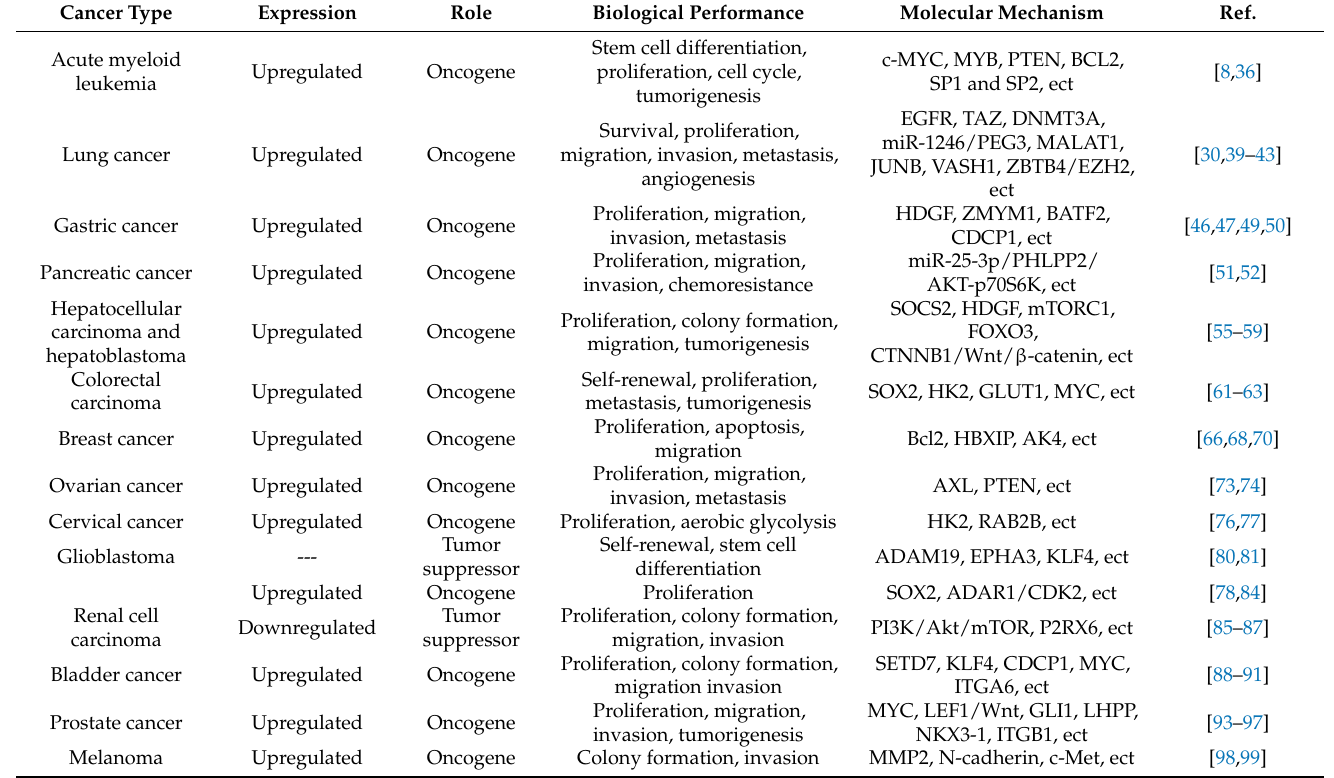
Table 1. Expression, role, biological performance and molecular mechanisms of METTL3 in various